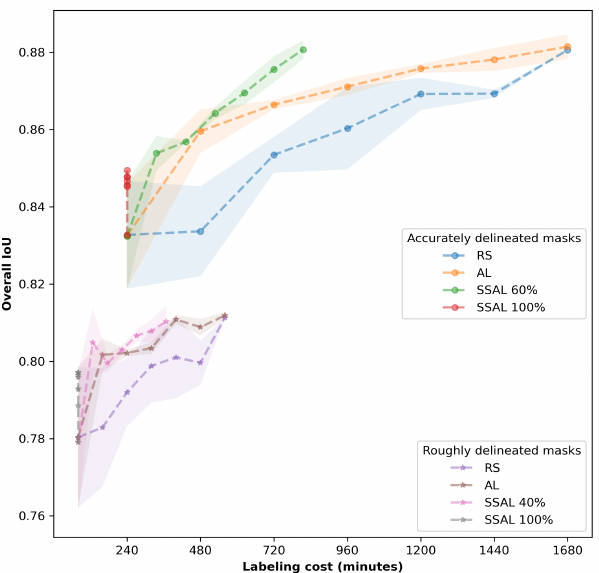
Figure 5. Accuracy (overall IoU ) and labeling cost for different strategies on accurately and roughly delineated masks (i.e., random selection (RS), active learning (AL), semisupervised active learning strategies (SSAL 60%, 40% and 100%)). For accurately delineated masks, the 60% strategy yielded the best results and for roughly delineated masks the 40% strategy yielded the best results. Table 2. Labeling cost and accuracy comparison among active learning (AL) and different semisuper- vised active learning (SSAL)